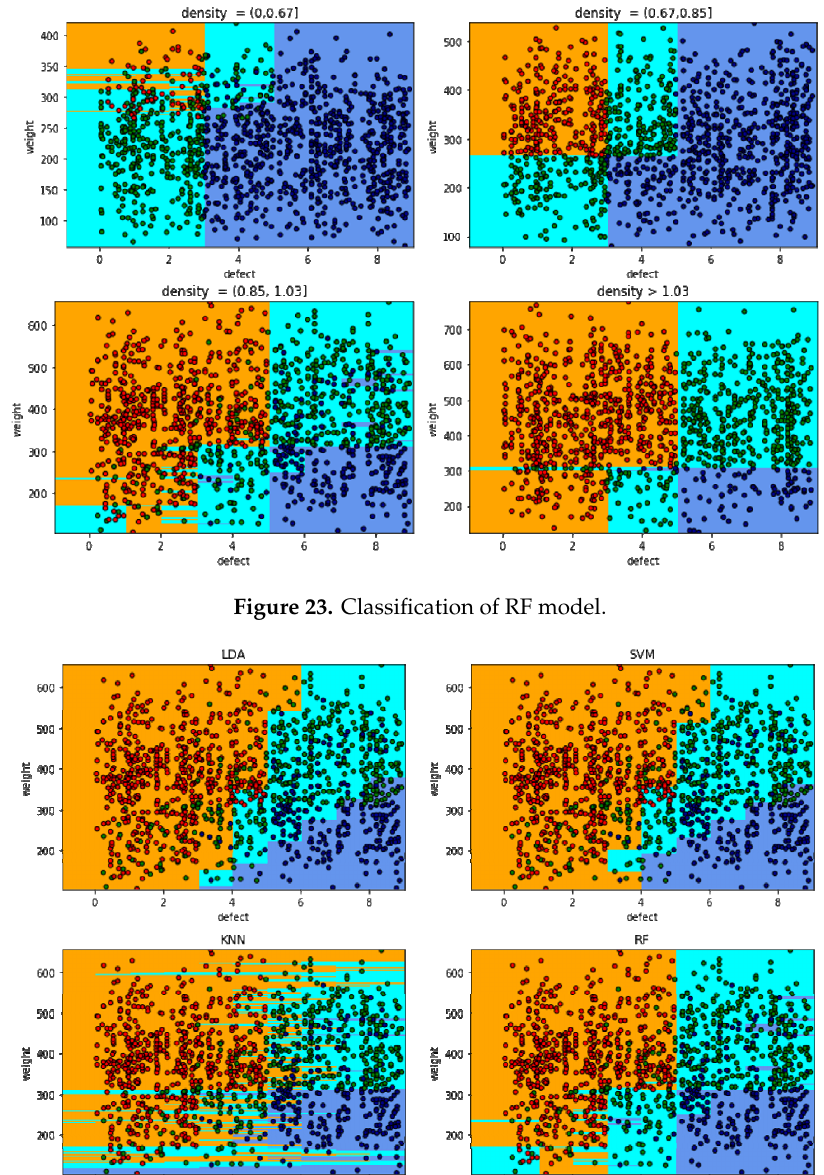
Figure 24. The comparison of four models include LDA, SVM, KNN, and RF.